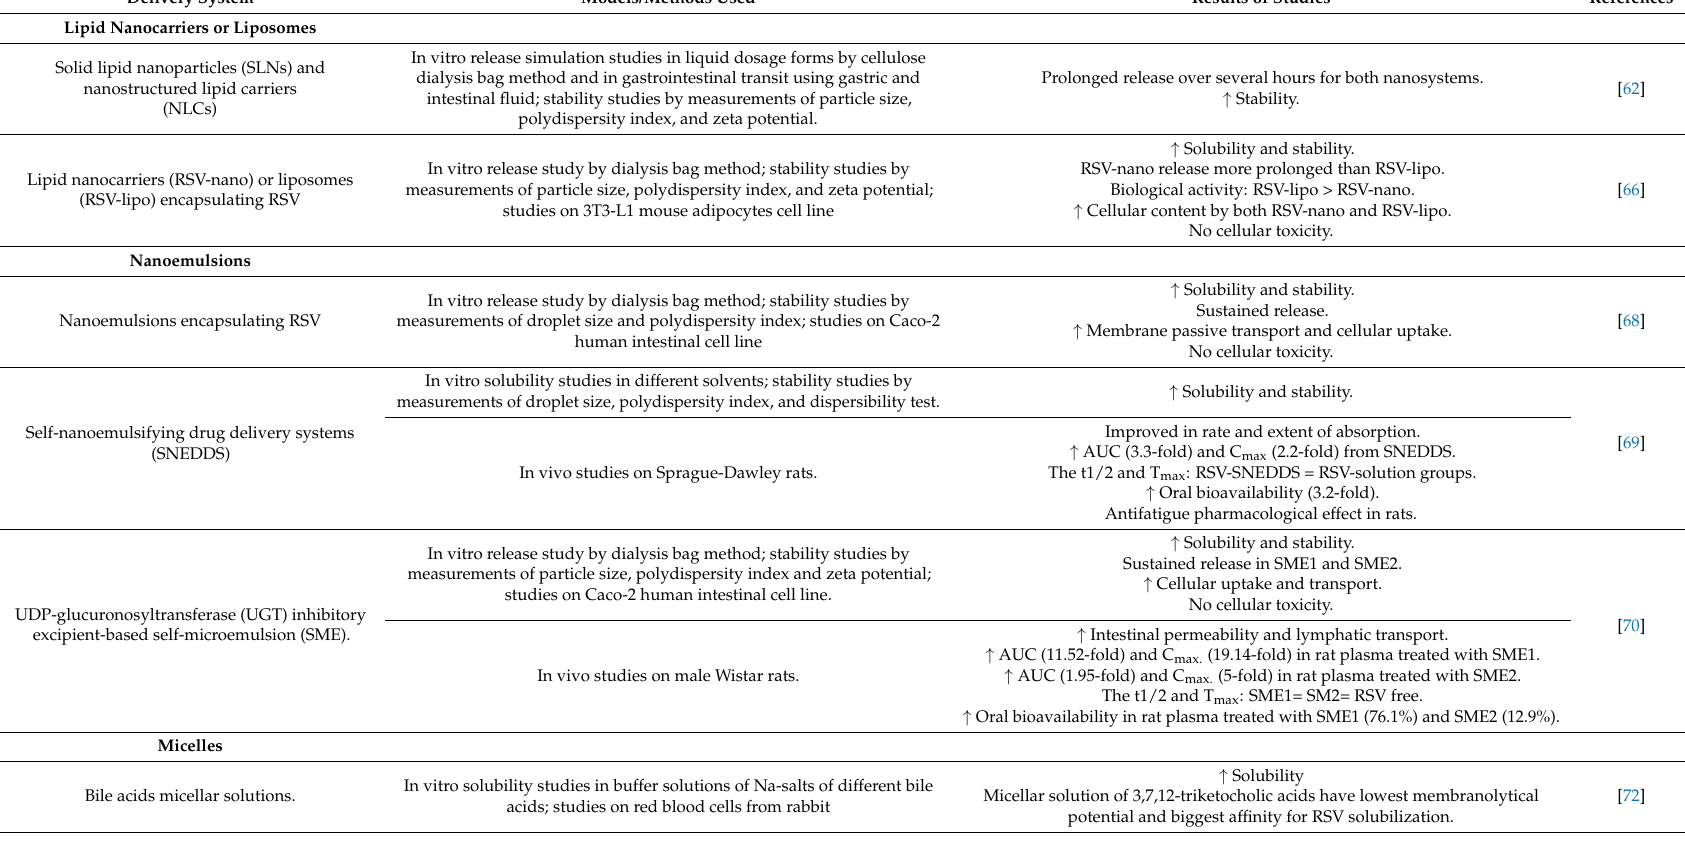
Table 2. Principal characteristics of resveratrol (RSV) delivery systems for improving its oral bioavailability. For some studies in the table the common pharmacokinetic parameters of RSV are reported. SME-1 and -2: self-microemulsion containing excipients with or without inhibitory activities, respectively; AUC: